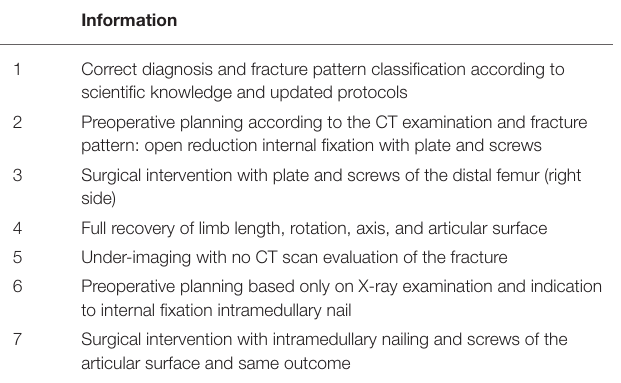
TABLE 3 | Information needed for the process of case study two.